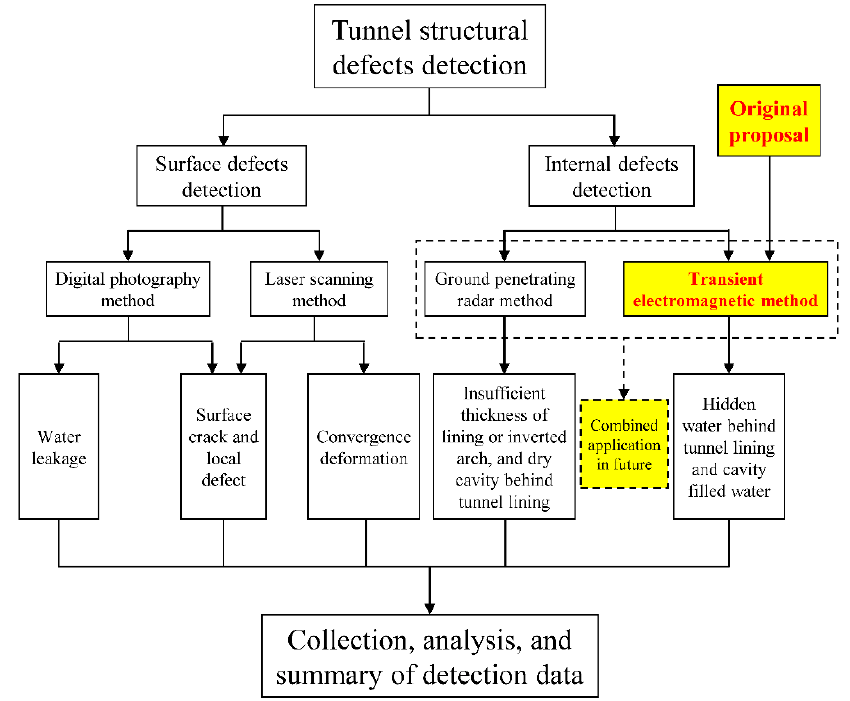
Figure 5. Detection method of tunnel structural defects.